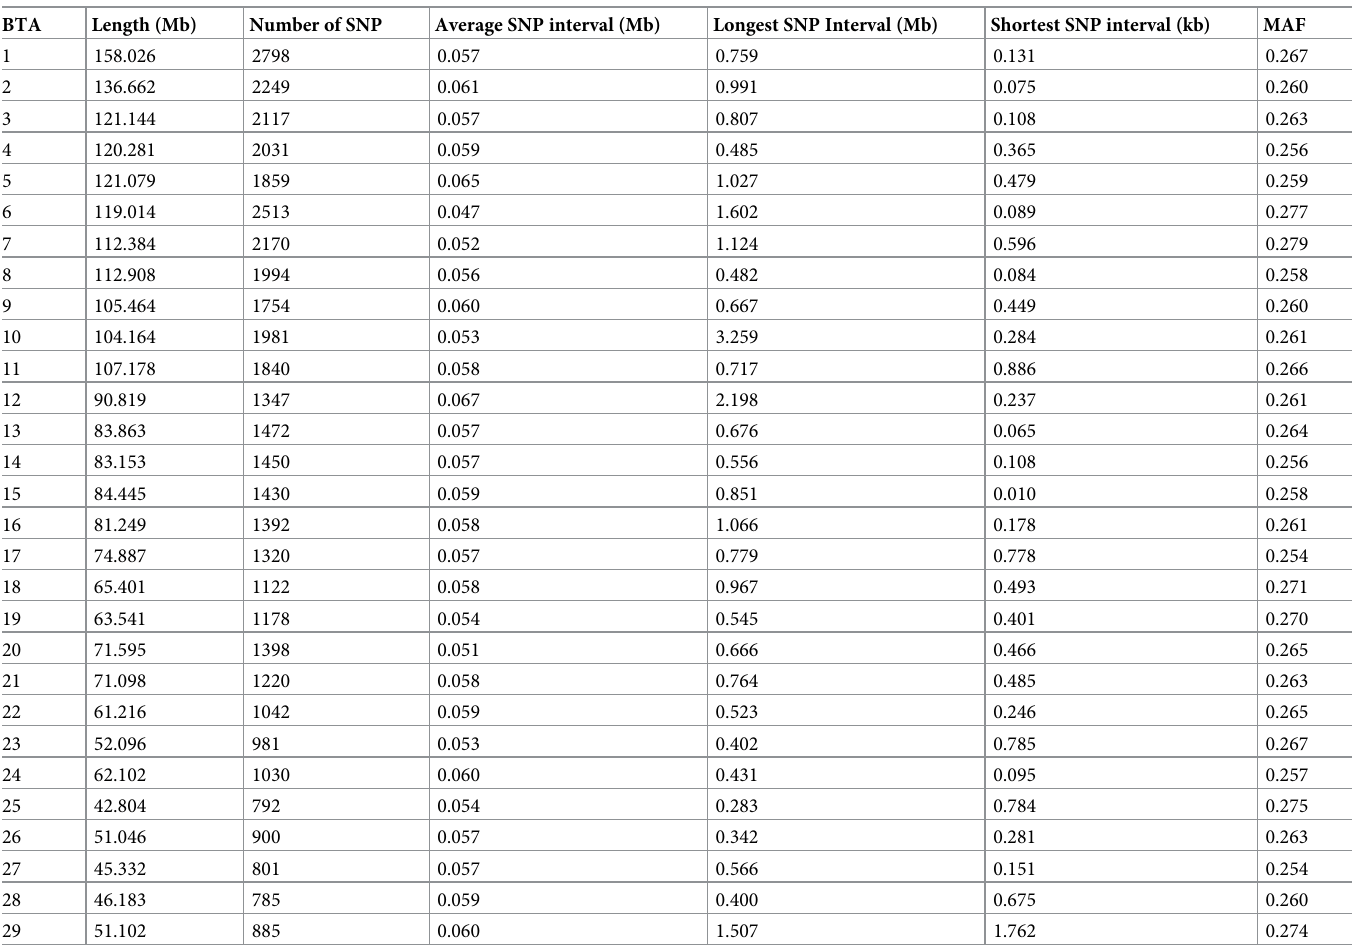
Table 1. Summary of the SNP markers analyzed and minor allele frequency for each autosomal chromosome